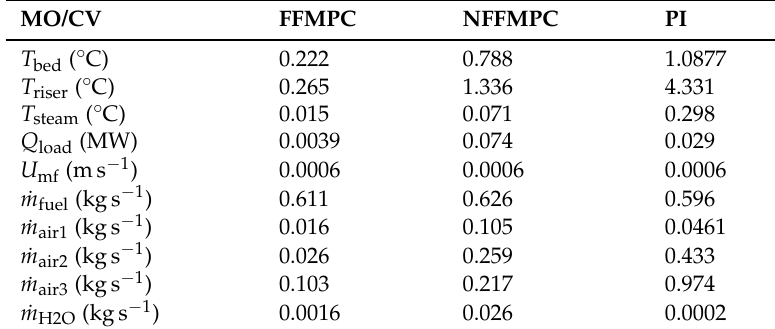
Table 2. The standard deviation in the measured output performance and control variables in all three